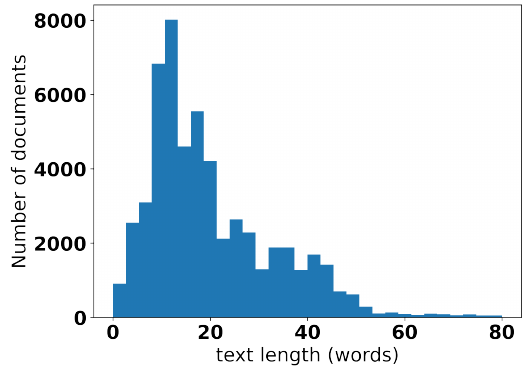
Figure 3. The distribution of text